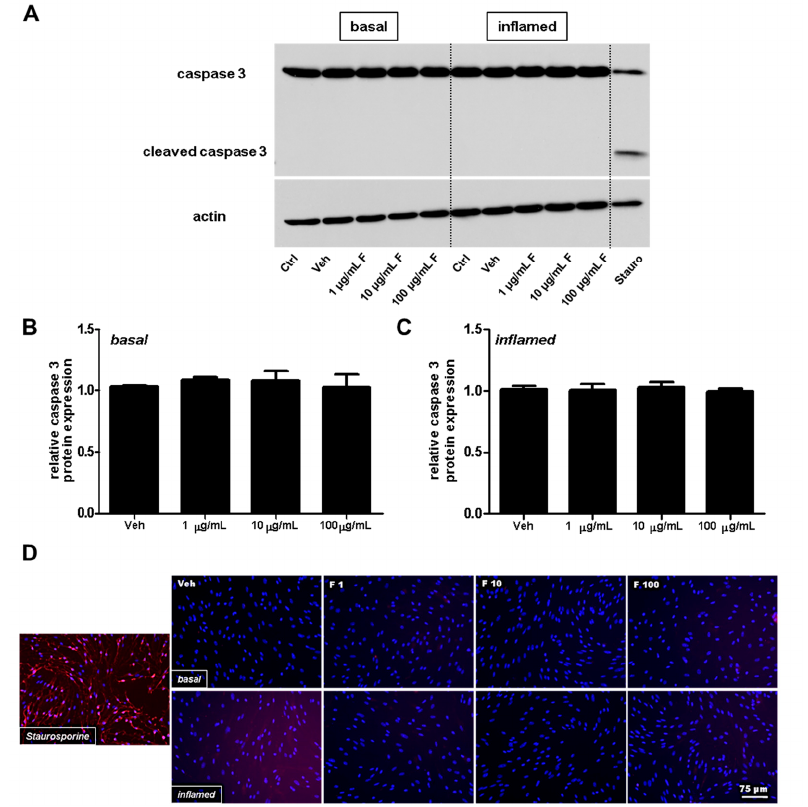
Figure 2. Analysis of apoptosis in mouse brain microvascular endothelial cells (MBMEC) exposed to different doses of fullerenols under basal and inflammatory conditions. ( A ) Representative Western blot analyses of full-length caspase 3 protein expression in MBMEC cultures after exposure to interferon- γ and tumor necrosis factor- α (I + T; 100 IU each) and treatment with fullerenols (F; 1, 10 and 100 µ g/mL; n = 3) for 18 h compared to cultures under basal conditions. Staurosporine treatment (Stauro; 1 µ M for 2 h) was used as a positive control; ( B ) Densitometric quantification of the amount of full-length caspase 3 in MBMEC, treated with different doses of fullerenols or vehicle (normalized to untreated control cells) cultured for 18 h under basal conditions; ( C ) Densitometric quantification of the amount of full-length caspase 3 in MBMEC, treated with different doses of fullerenols or vehicle (normalized to untreated control cells) cultured for 18 h under inflammatory conditions; ( D ) Representative immunofluorescence images of cleaved caspase 3 (red) counterstained with Hoechst (blue) in MBMEC treated with fullerenols (F 1, 1 µ g/mL; F 10, 10 µ g/mL; F 100, 100 µ g/mL) for 18 h under basal or inflamed (I + T; 100 IU each) conditions. Staurosporine treatment (1 µ M for 2 h) was used as a positive control. Scale bar counts